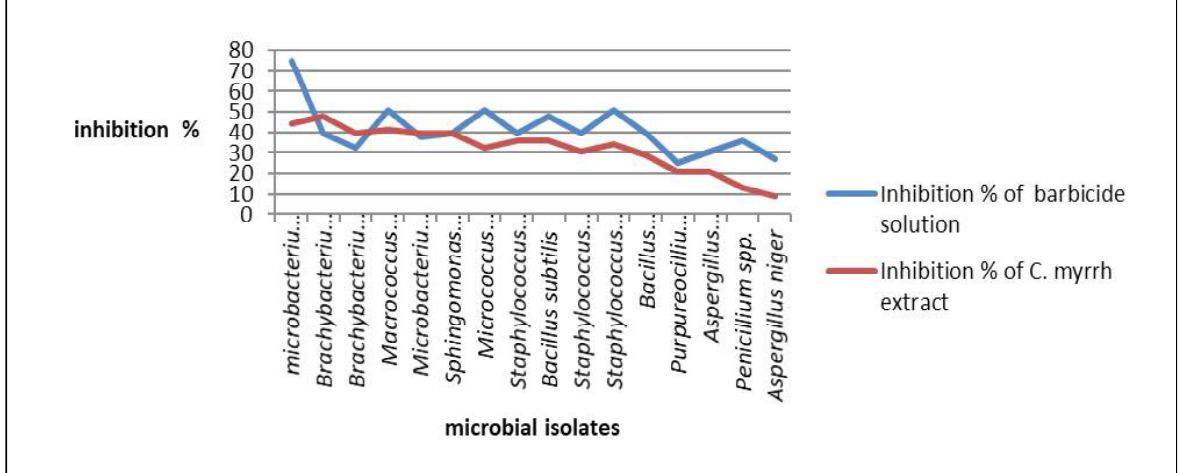
Figure 11: Comparison of the Inhibition % of C. myrrh extract with the Inhibition % of barbicide